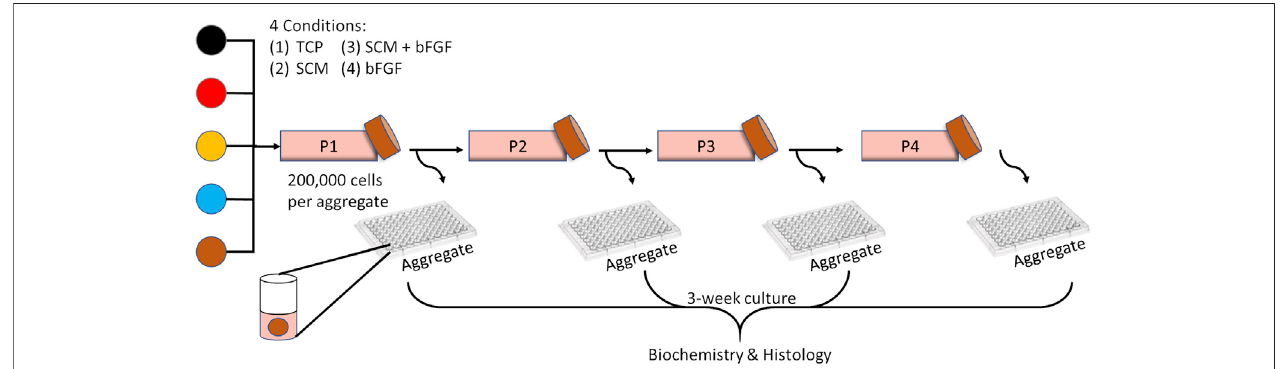
FIGURE 1 | Experimental overview. Human chondrocytes from fi ve donors (each color represents a donor) were expanded for four passages on tissue culture plastic(TCP),synoviocyte-derivedextracellularmatrix(SCM),onsynoviocytematrixwithbFGF(SCM+bFGF),orontissuecultureplasticwithbFGF(bFGF).Attheendof each expansion period, the chondrocytes were trypsinized and seeded as aggregates and passaged to a new fl ask of the same type.